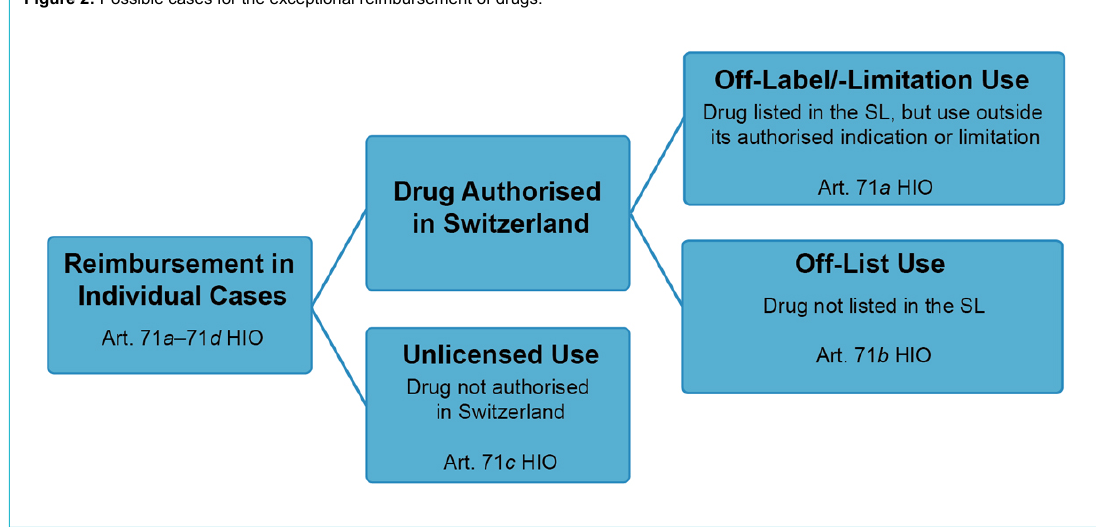
Figure 2: Possible cases for the exceptional reimbursement of